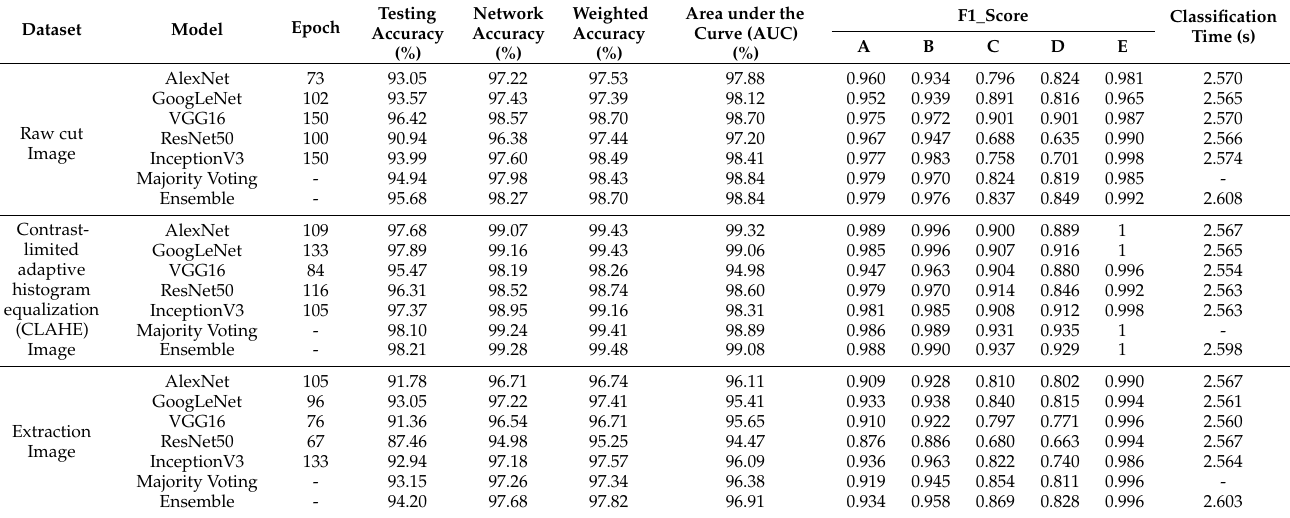
Table 3. Comparison of the performance for each transfer learning